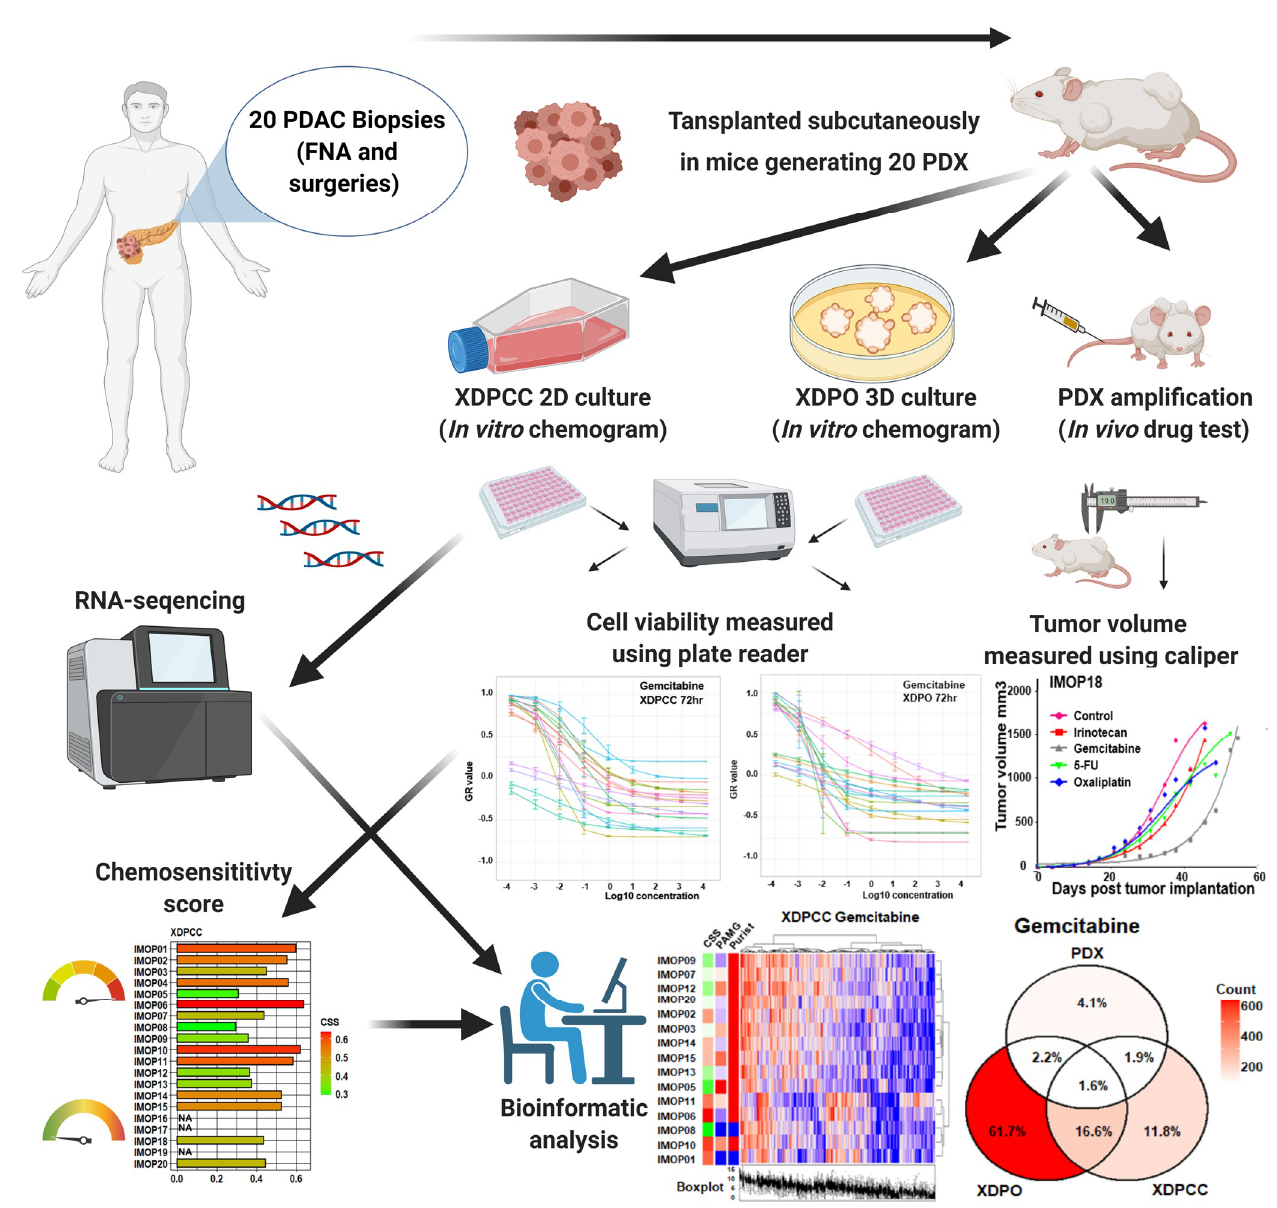
Figure 1. Study workflow. 20 PDAC tumors including surgical resections and fine needle aspirated (FNE) biopsy were subcutaneously transplanted in mice and allowed to grow. From these 20 PDX samples, XDPO and XDPCC were also derived and amplified in culture. Mice were later treated with chemotherapeutics, which were administered intravenously into the tail vein of the mouse. Measurements were taken periodically at set time intervals using a caliper device. Chemosensitivity testing was performed on PDX, XDPO and XDPCC samples and each model also underwent RNA-sequencing for further transcriptional downstream analysis.